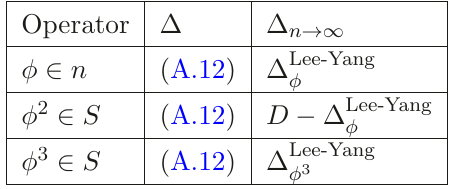
Table 3 . Scaling dimensions for continuum N-state Potts from φ 3